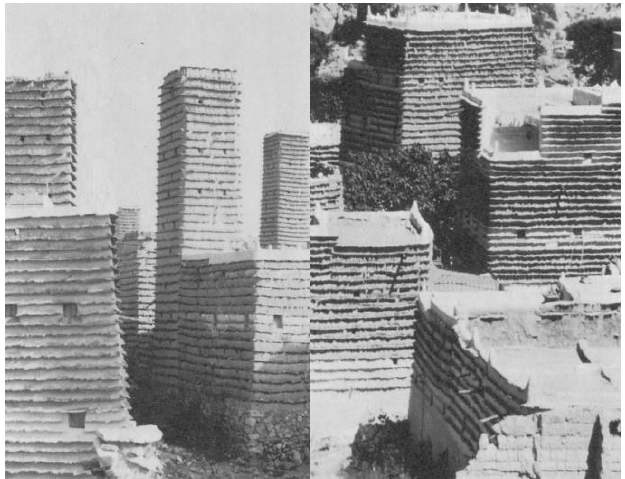
Figure 4. The vernacular house of the Asir type [54].